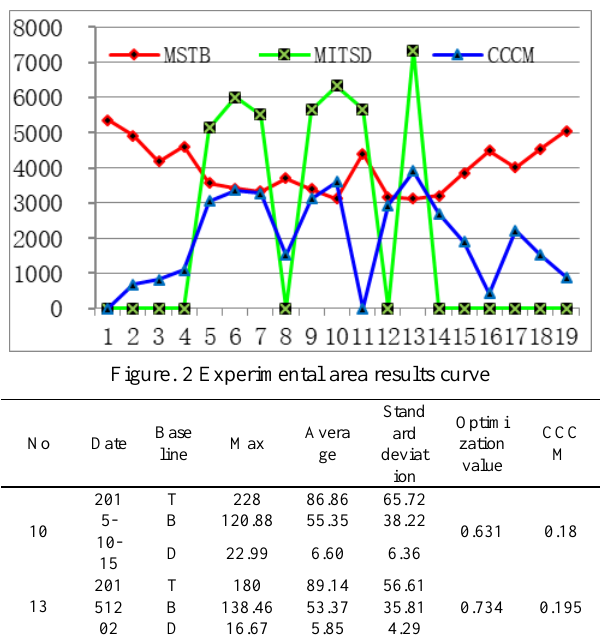
Table 3. Baseline values of images numbered 10 and 13